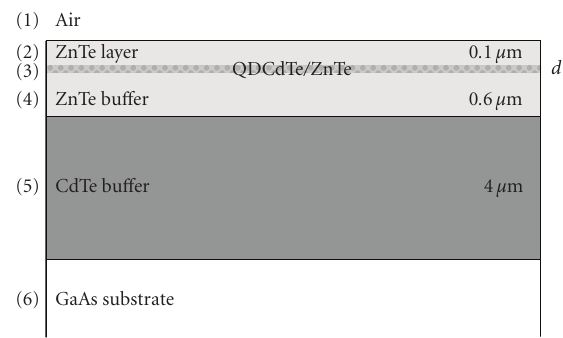
Figure 1: A schematic presentation of a six-layer structure.